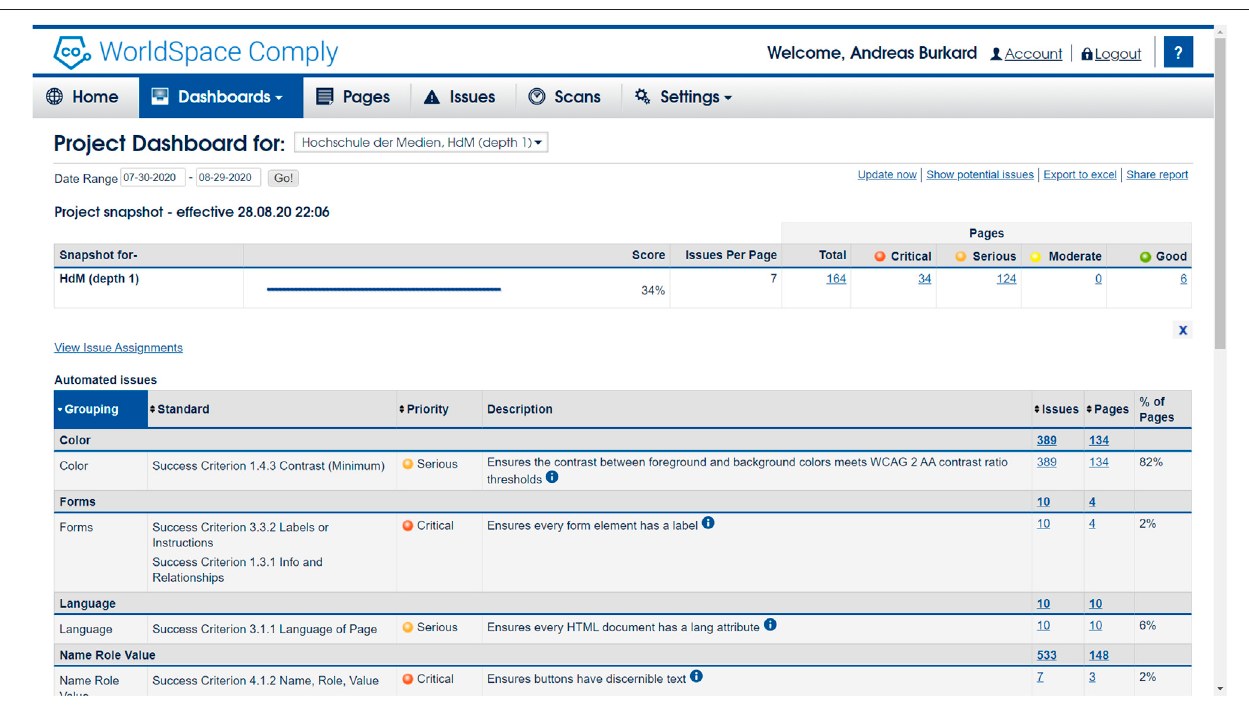
FIGURE 3 | axe Monitor (formerly WordSpace Comply ) project dashboard.